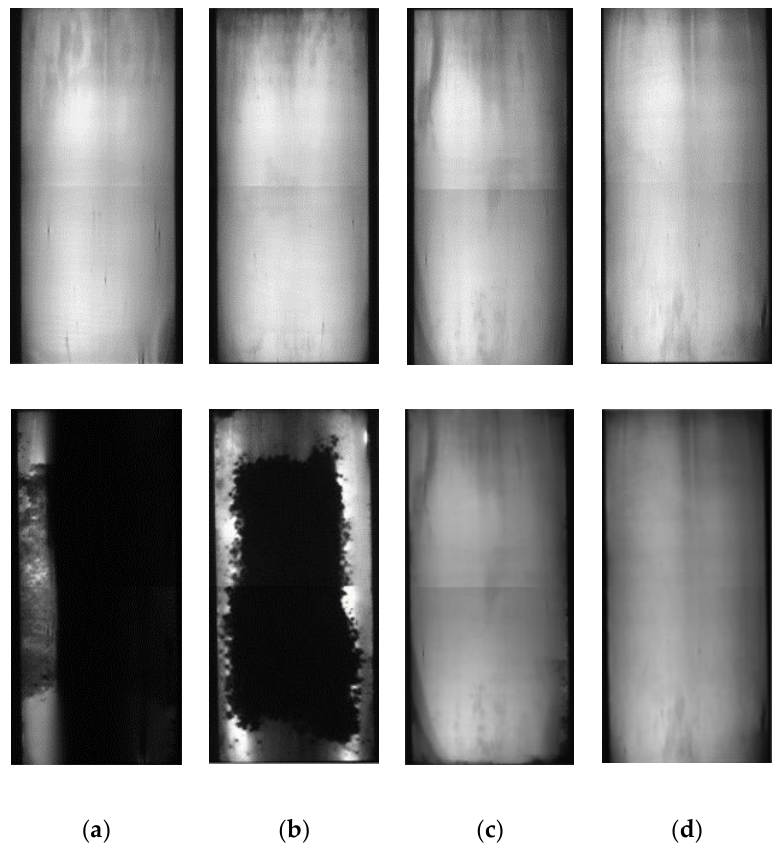
Figure 9. EL images of the tested modules at 85 °C and 85% RH, before (upper images) and after (lower images) the test for different contacts: ( a ) front, ( b ) back, ( c ) frame, and ( d ) unbiased.